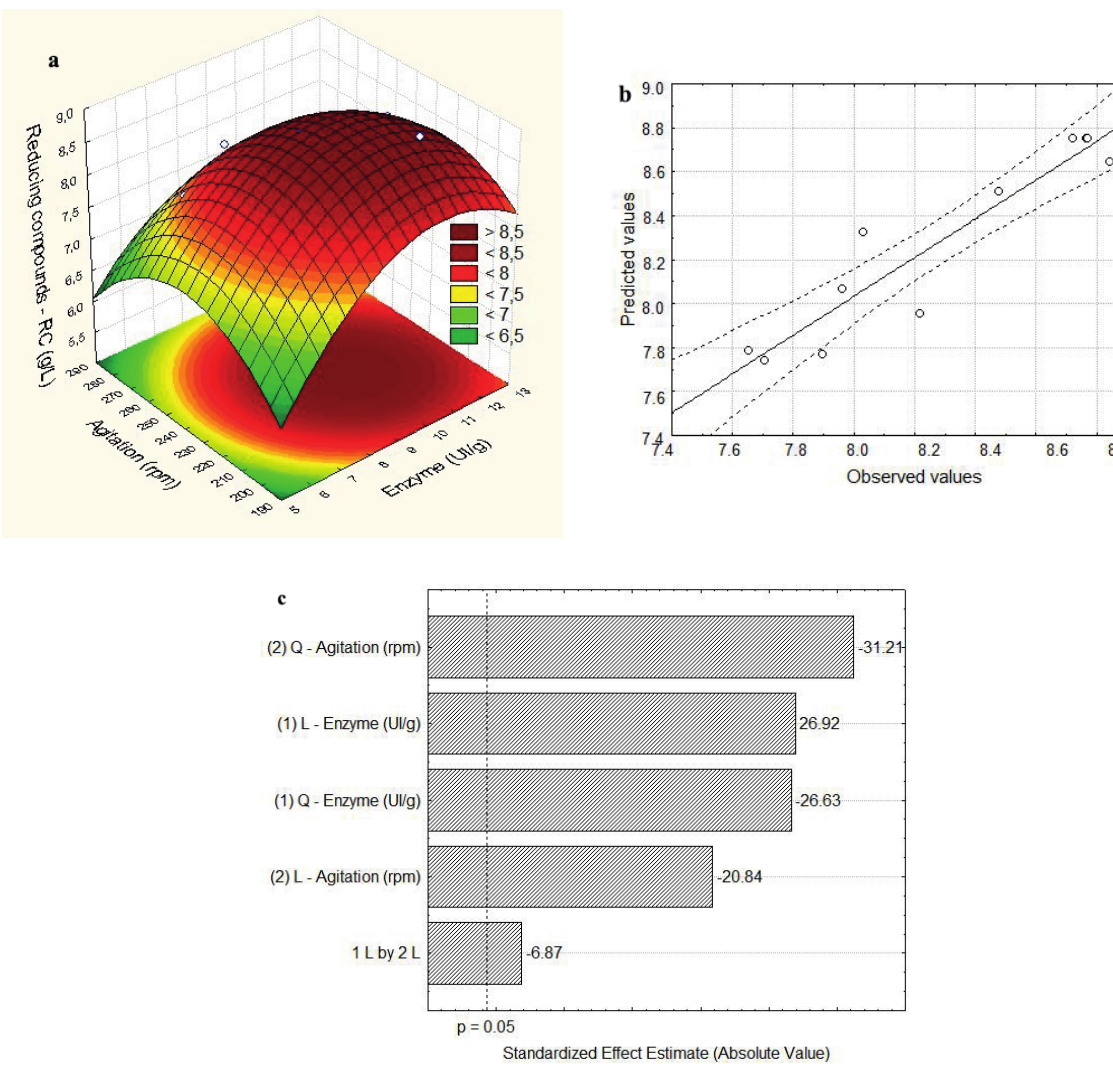
Figure 2 - experimental design to pectin enzymatic hydrolysis optimization - response surface ( a ), distribution of residuals ( b ), and Pareto chart ( c ) as a function of independent variables: agitation speed and enzyme concentration, and response variable: reducing compounds (RCs)